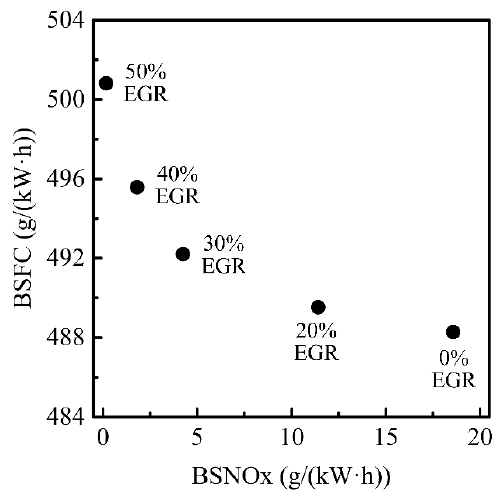
Figure 15. BSFC–BSNOx trade-off for the CDAc + EGR mode with the EGR rate from 0 to 50% at an engine speed of 450 rpm and an engine load of 1000 N ∙ m (the emission results were transformed from 3D simulation of ESE DIESEL).